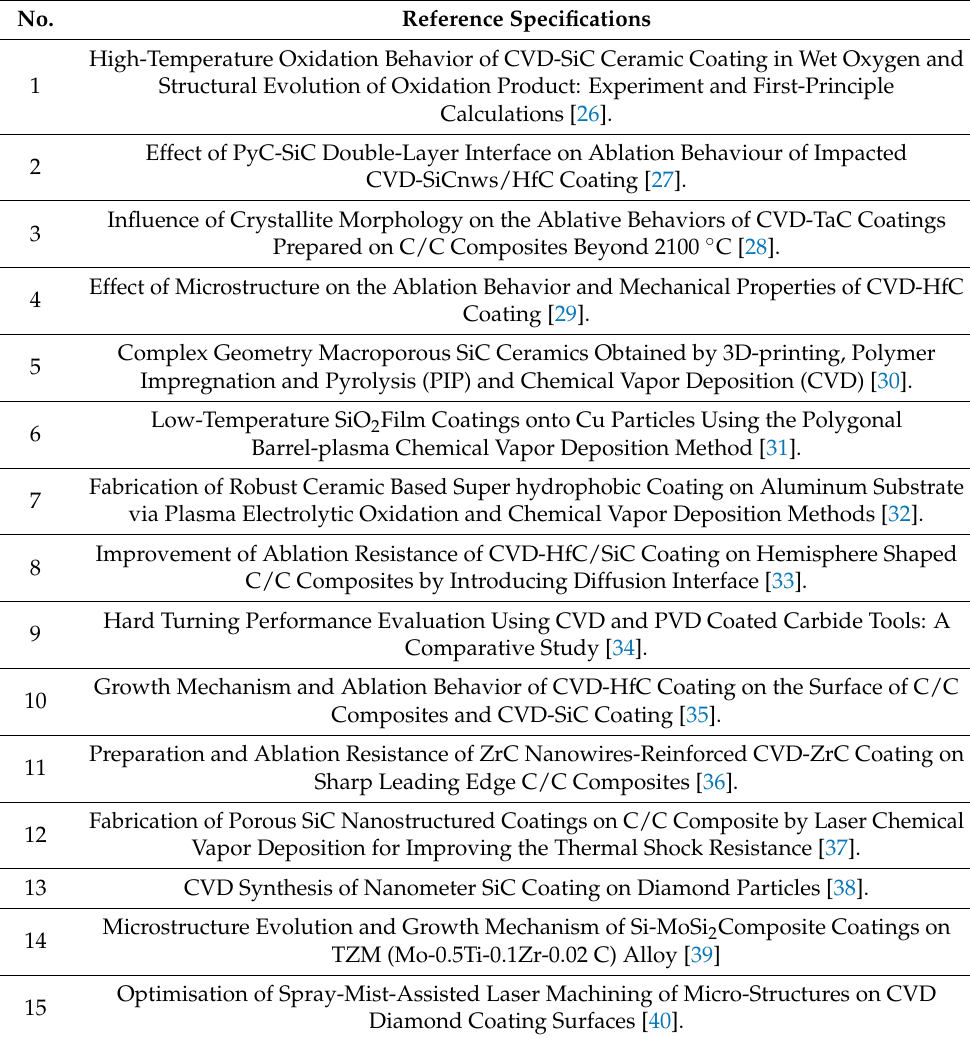
Table 1. Example publications demonstrating the range of ceramic coatings prepared by the CVD